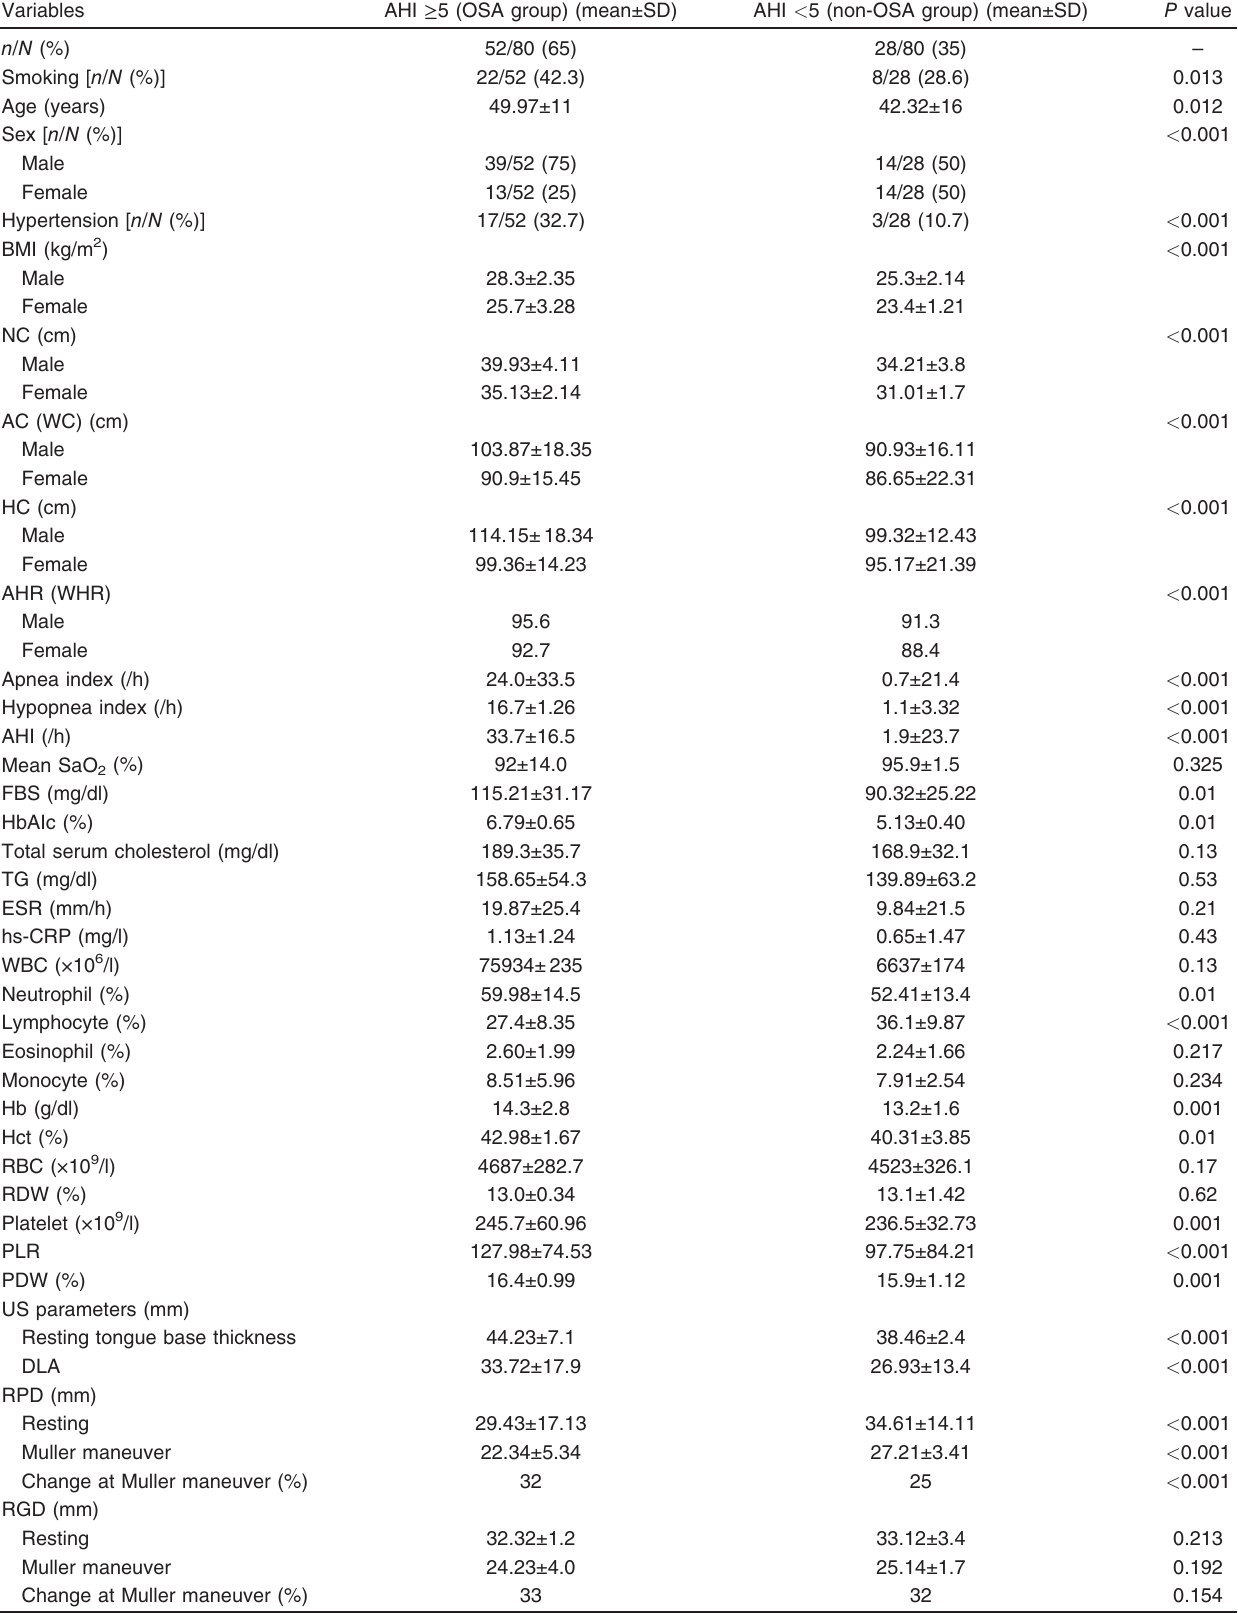
Table 1 Baseline characteristics, demographic data, polysomnographic and ultrasonic parameters, and laboratory values among the studied